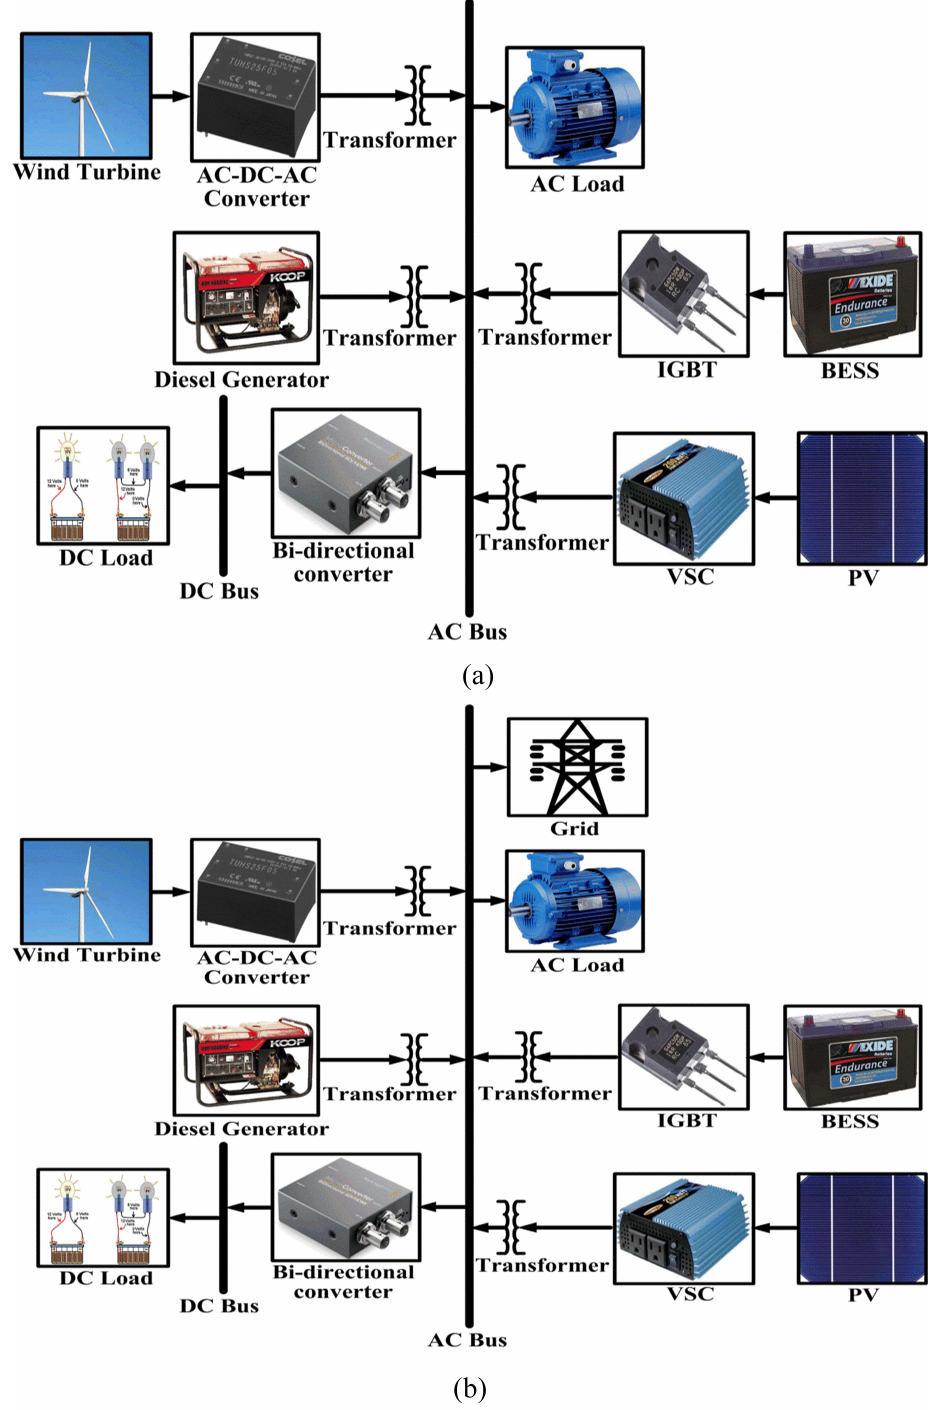
Figure 1. Schematic diagram of solar-wind hybrid microgrid ( a ) islanded and ( b ) grid-connected